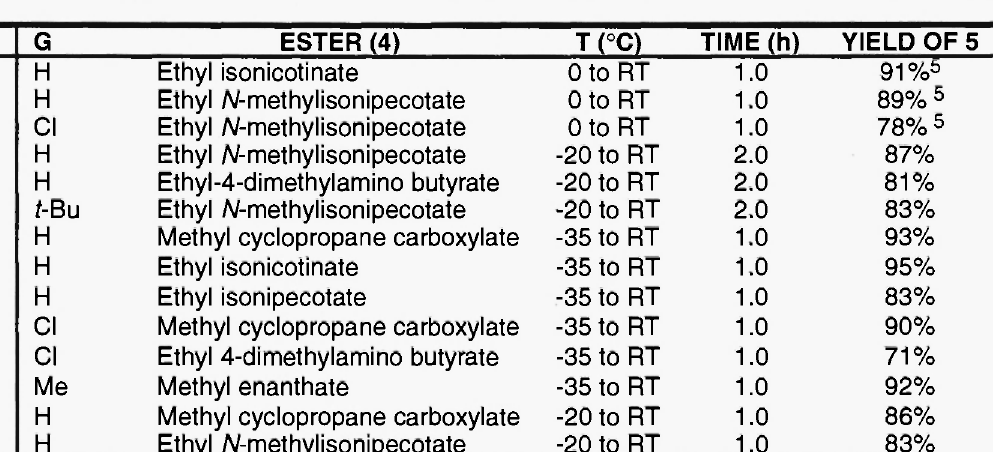
Table 2. Yields for reactions between dilithio-diaryl species (2) with different ester electrophiles